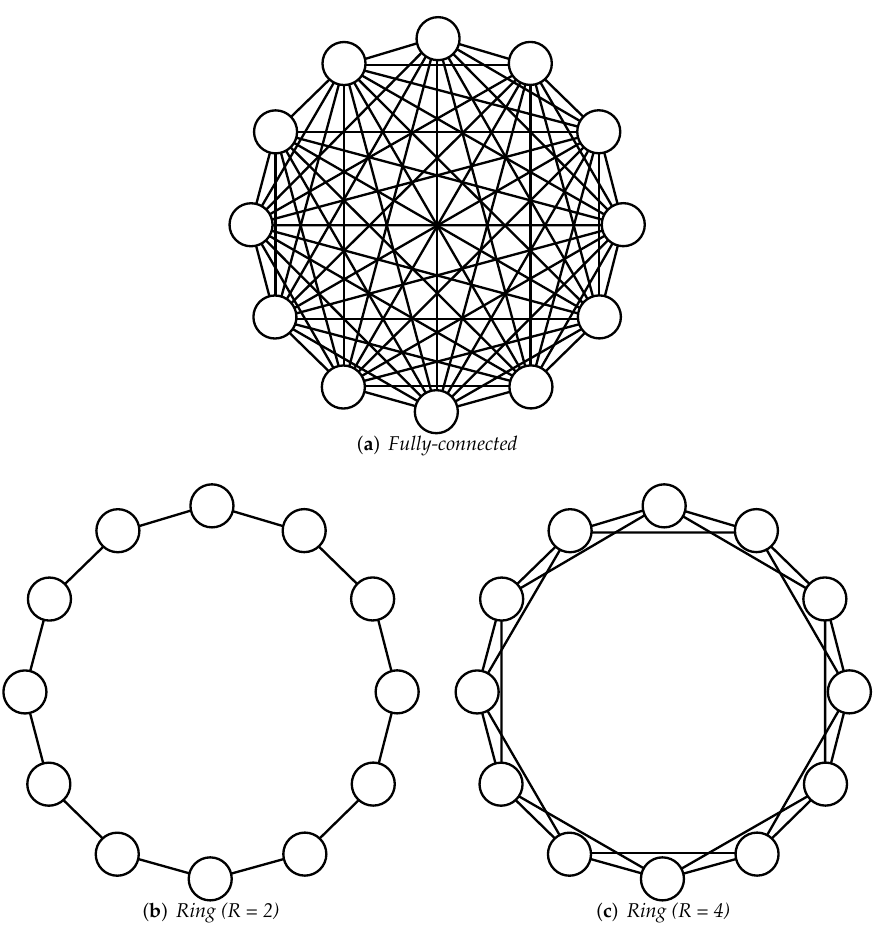
Figure 1. Some examples of PSO Neighborhood Topologies.